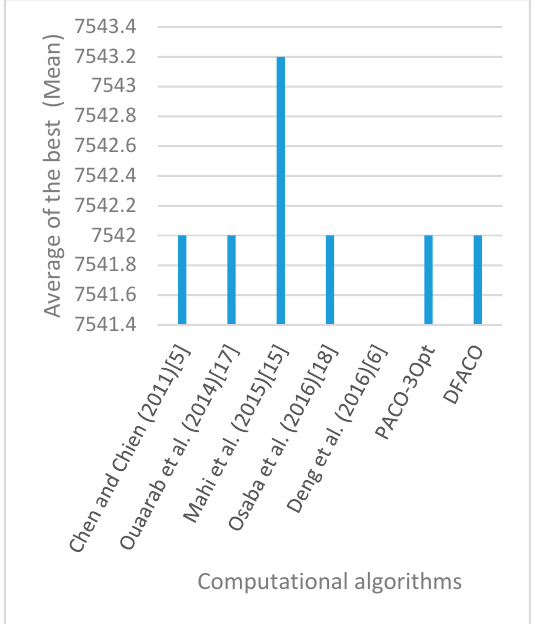
Figure 11. Average of best solutions obtained for instance berlin52 by all algorithms.